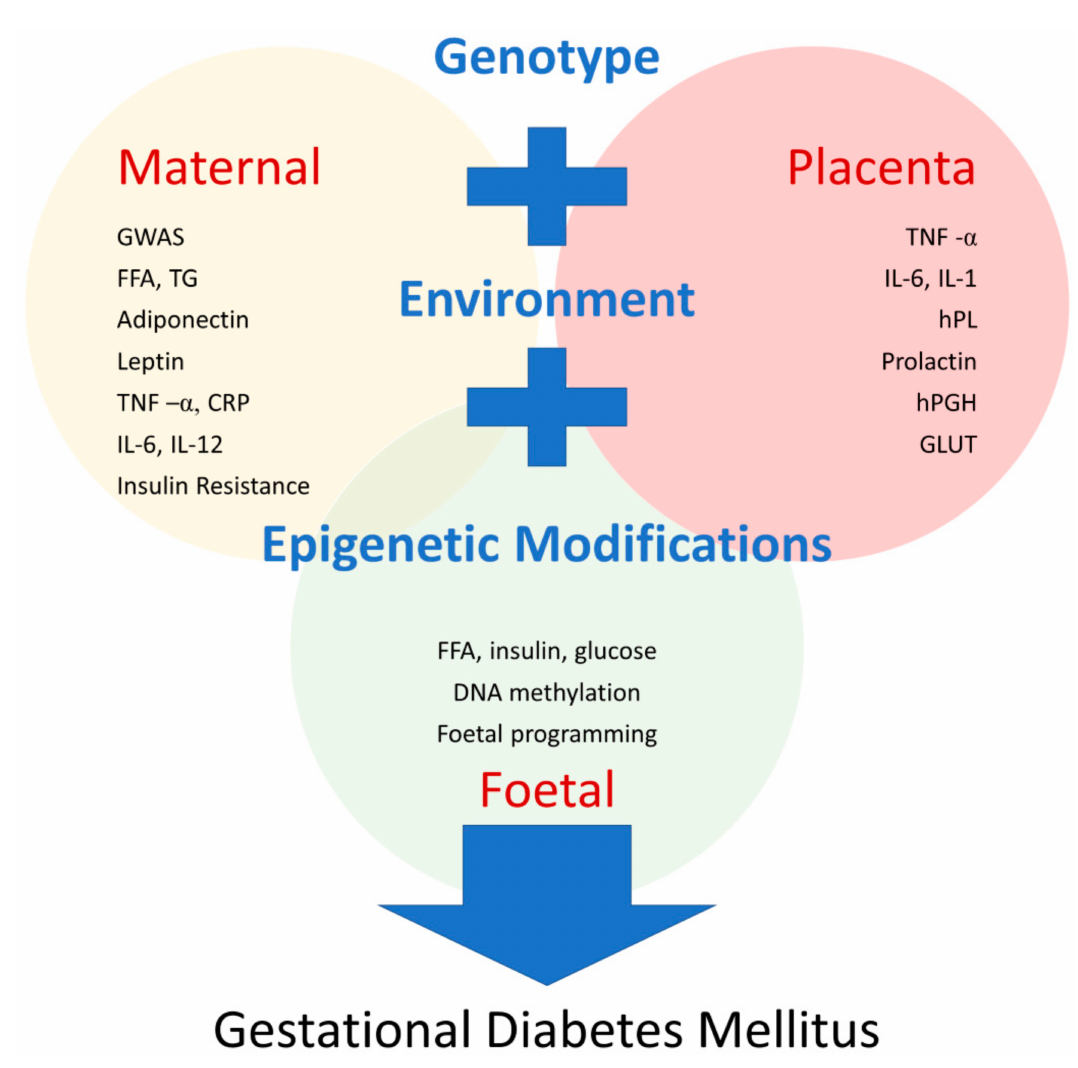
Figure 1. Known pathophysiologic mechanisms in GDM. These mechanisms give rise to potential biomarkers to predict GDM development. There is a complex interplay between maternal, foetal, and placental factors at a cellular level involving genetic, environmental, and epigenetic